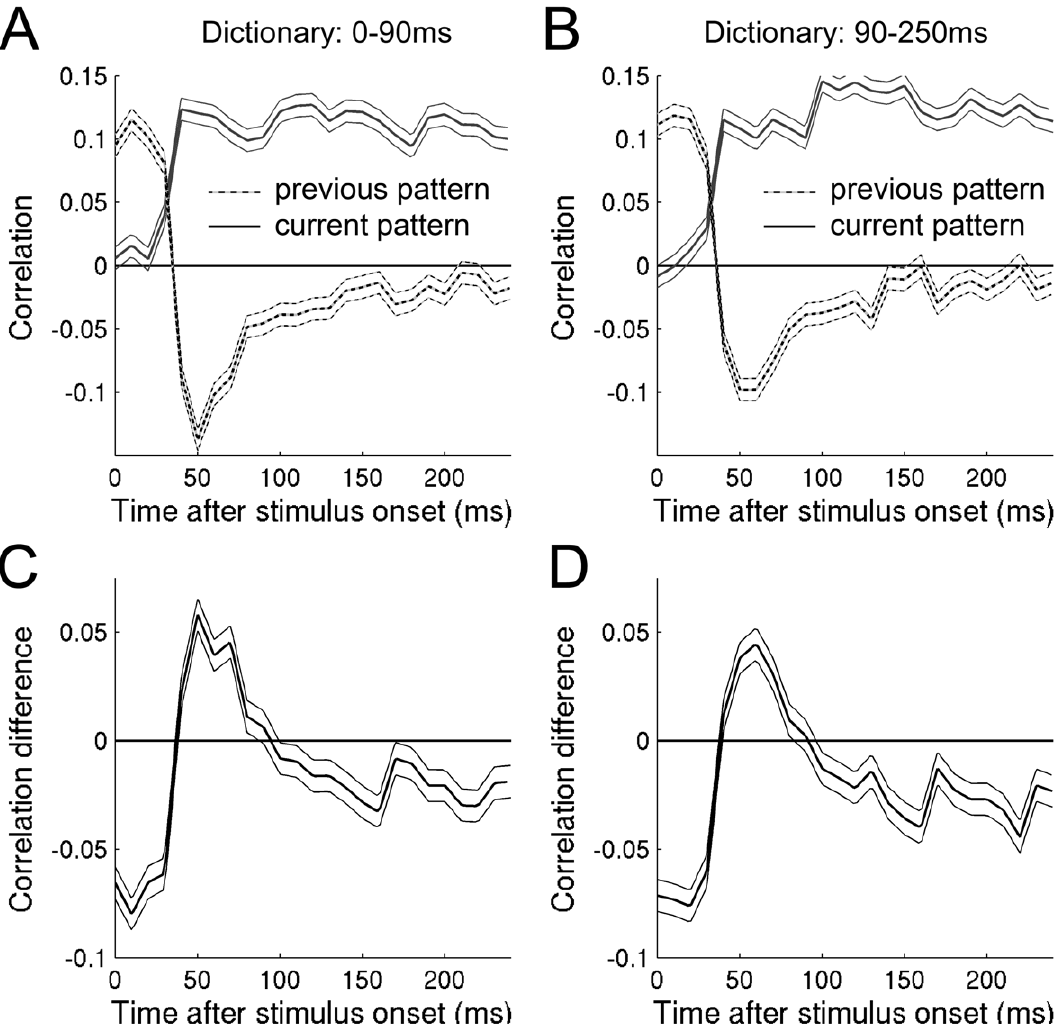
Figure 5. Dictionary estimated at two different time points. The decoding was done using two different firing rate codes. Either the code was the average firing rate between 0–90 ms after the blank to pattern transition (A), or the average firing rate between 90–250 ms after the blank to pattern transition (B). The difference between the correlation with the difference pattern and the current pattern was done for both codes (C, D). Note that both codes generated similar time courses.